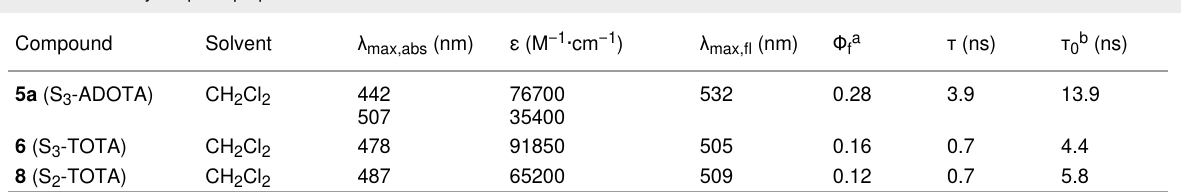
Table 3: Summary of optical properties of the fluorescent derivatives.